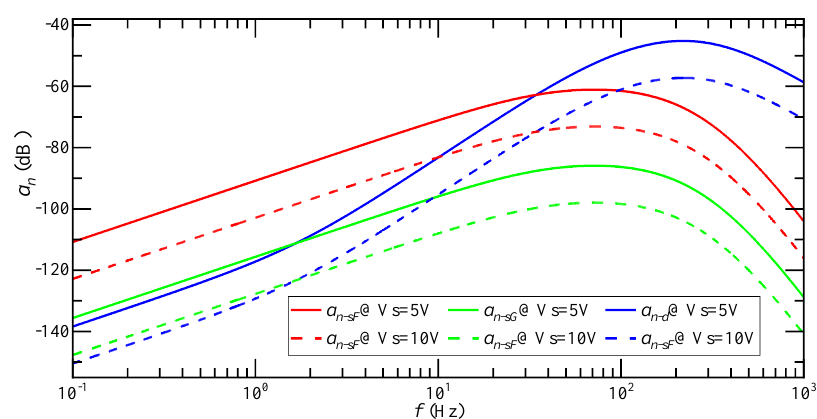
𝑎 𝑛−𝑑 is 10.4 μg, while can suppress the detection noise. can suppress the detection noise.